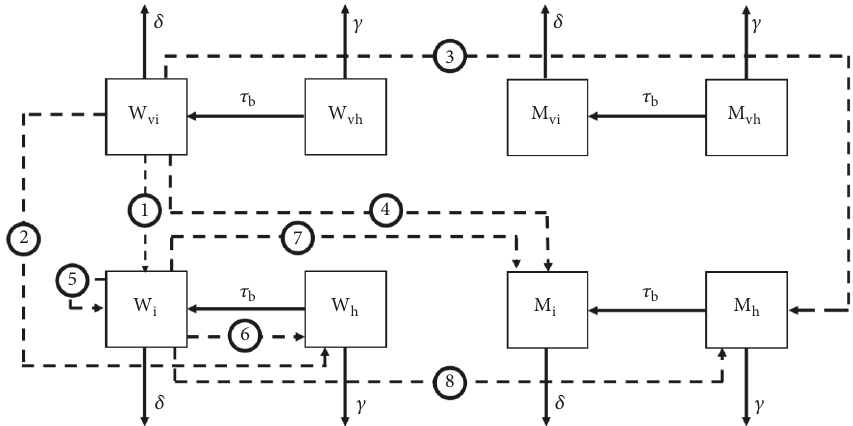
Figure 1: Flow chart for the dynamics of proposed model. Letters inside box indicate the number of individuals in each compartment: infected women from country with vector ( 𝑊 V 𝑖 ), healthy women from country with active vector transmission ( 𝑊 V ℎ ), infected men from countrywithactivevectortransmission( 𝑀 V 𝑖 ),healthymenfromcountrywithactivevectortransmission( 𝑀 V ℎ ),infectedwomenfromcountry without vectortransmission ( 𝑊 𝑖 ), healthy women from country without vector transmission ( 𝑊 ℎ ), infected men from country without vector transmission( 𝑀 𝑖 ), and healthy men from country without vector transmission ( 𝑀 ℎ ). 𝛾 is the death rate for healthy people and 𝛿 is the death rate for infected people. 𝜏 𝑏 is the rate of infection due to blood transfusion. Dashed lines indicate the births. Newborns from 𝑊 V 𝑖 can be an infected female (1), healthy female (2), healthy male (3), or infected male (4). The same occur for newborns from 𝑊 𝑖 that can be infected female (5), healthy female (6), infected male (7), or healthy male (8). Healthy women 𝑊 V ℎ and 𝑊 ℎ only gave birth to healthy newborns (flows not